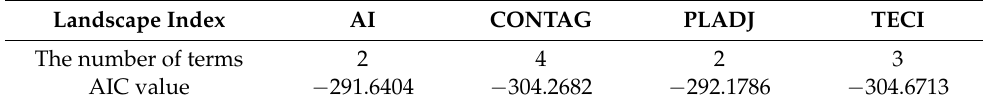
Table 5. The table of terms number of Gaussian landscape index. Landscape Index AI CONTAG PLADJ TECI The number of terms 2 4 2 3 AIC value − 291.6404 − 304.2682 − 292.1786 − 304.6713